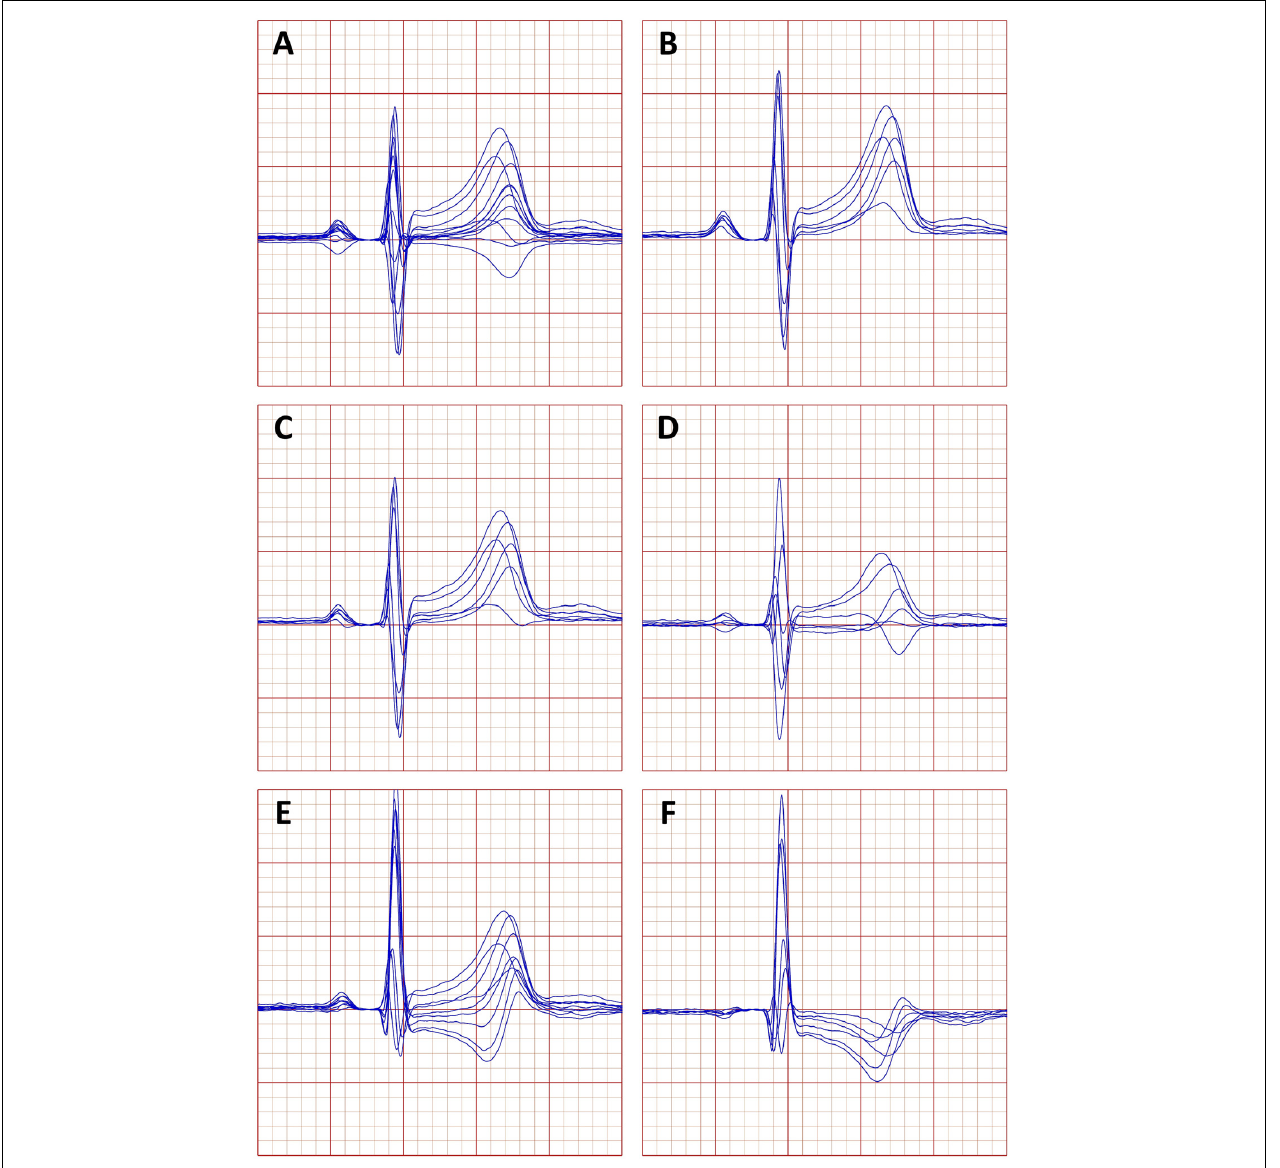
FIGURE 1 | Example of a representative beatform of an electrocardiogram (ECG) obtained in a 33-year-old male. (A) Standard leads of the 12 lead ECG, (B) the bipolar leads between the precordial electrodes and the right arm electrode, (C) the bipolar leads between the precordial electrodes and the left arm electrode, (D) the bipolar leads between the precordial electrodes and the left foot electrode, (E) the “wide” precordial dipoles, and (F) the “narrow” precordial electrodes (see the text for explanation of the precordial dipoles).